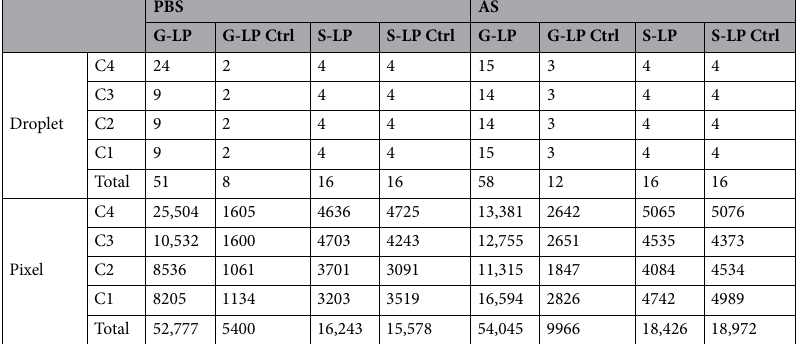
Table 1. Experiment 1: Sample distribution of synthetic viral models (SARS-CoV-2 spike pseudotyped lentiviral particles (S-LP) and lentiviral particles pseudotyped with the G protein of the vesicular stomatitis virus (G-LP)) and their respective negative controls (S-LP Ctrl and G-LP Ctrl) in phosphate buffered solution (PBS) and in artificial saliva (AS) at droplet and pixel levels. Concentrations were C1 = 800 TU µL −1 , C2 =